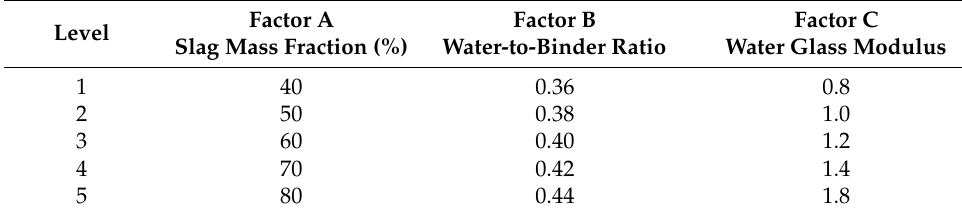
Table 4. The factors and levels of tests.